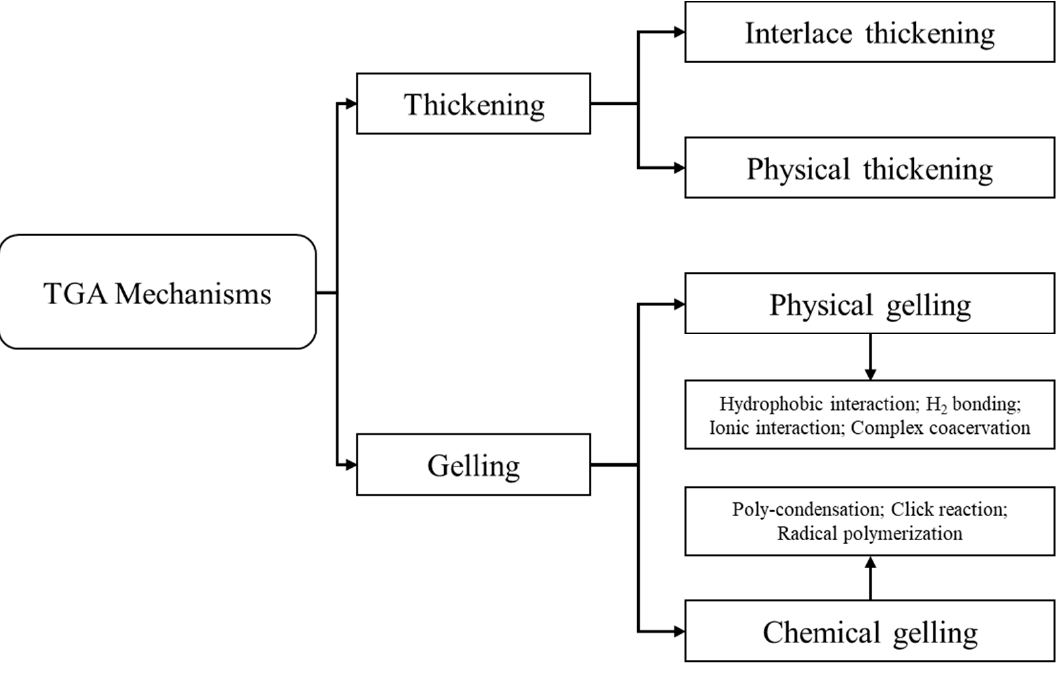
Figure 5. GTA mechanisms [28].